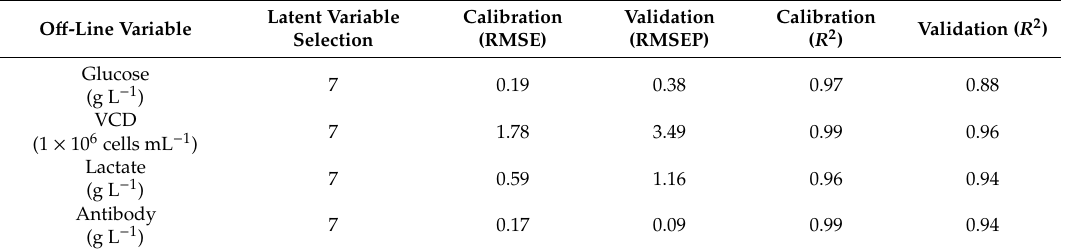
Table 1. Summary of the partial least squares (PLS) latent variable selection and model statistics for the o ff -line variables of glucose, VCD, lactate, and antibody concentration. O ff -Line